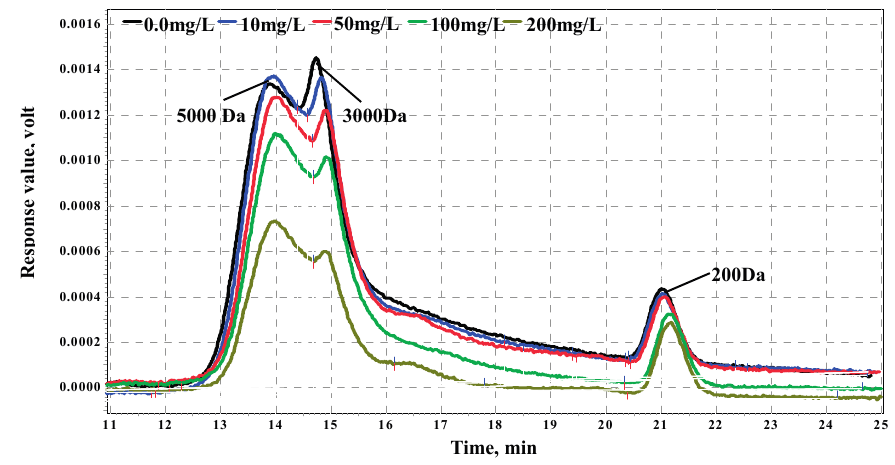
Figure 3. Effect of PAC on organics molecular weight distribution.